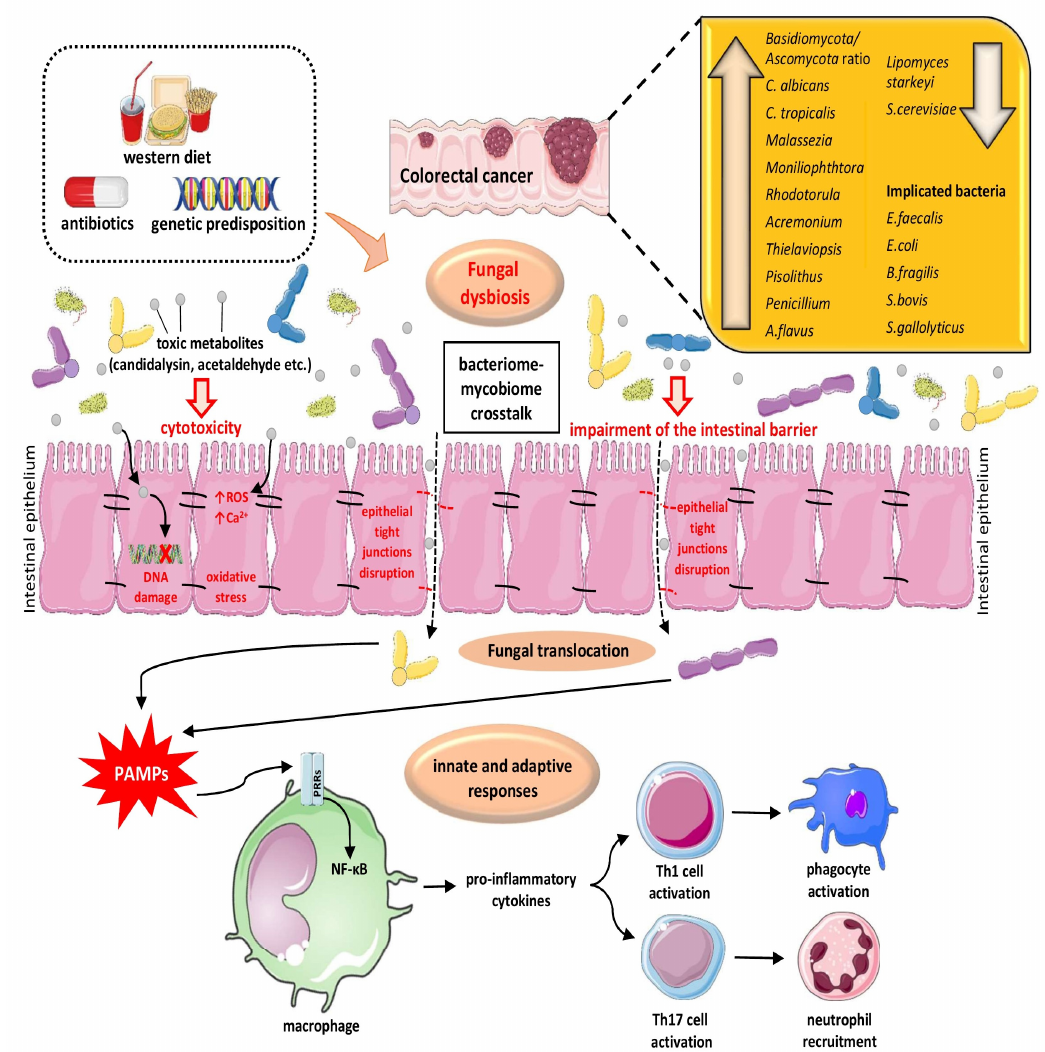
Figure 2. Fungal dysbiosis is the result of a multi-factorial process involving various environmental parameters, including Western-type nutrition and chronic administration of antibiotics as well as genetic predisposition, all resulting in impairment of the intestinal barrier and cellular tight junctions. This dysfunction induces opportunistic fungi translocation with consequences in the host innate and adaptive immune system. In macrophages, the interaction of fungal cell wall elements (PAMPs) by PRRs (e.g., CLRs) induces the secretion of pro-inflammatory cytokines, which leads to the Th1 and Th17 cells activation, provoking phagocyte stimulation and neutrophil chemotaxis. Furthermore, harmful metabolites produced by pathogenic fungi, such as acetaldehyde from Candida albicans and Candida tropicalis , and candidalysin from Candida albicans , may induce cytotoxicity and DNA damage, by provoking oxidative stress, via increased ROS production and the enhancement in intracellular Ca ++ levels. The interaction between the bacteriome and the mycobiome, i.e., the inter-kingdom interplay, is equally or even more important in the process of carcinogenesis in CRC. Abbreviations: Ca ++ : calcium cations; CLRs: C-type lectin receptors; CRC: colorectal cancer; NF- κ B: nuclear factor-kappa B; PAMPs: pathogen-associated molecular patterns; PRRs: pattern recognition receptors; ROS: reactive oxygen species; Th cell: T helper cell (All images are originated from the free medical website http://smart.servier.com/ (accessed on 25 May 2021) by Servier licensed under a Creative Commons Attribution 3.0 Unported License).